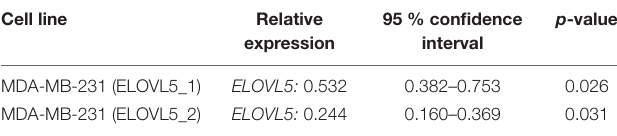
TABLE 1 | Relative expression of the ELOVL5 gene in the cells with a stable knockdown (shRNA) of the ELOVL5 gene compared to the control cells MDA-MB-231